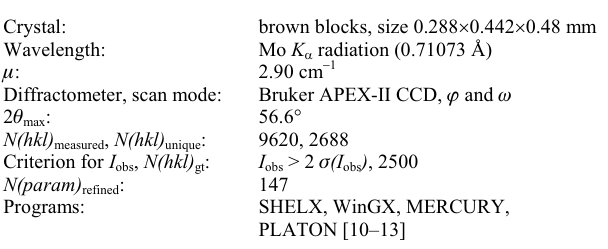
Table 1. Data collection and